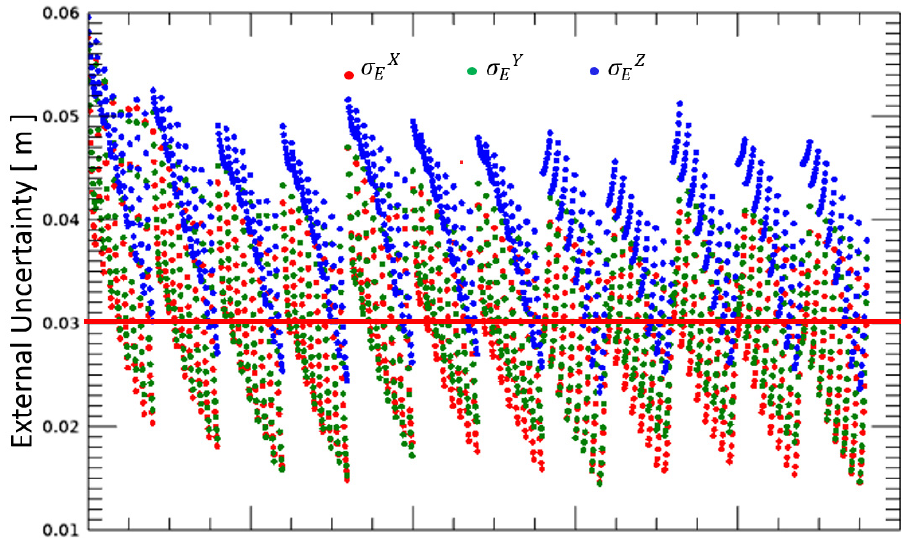
Figure 12. External uncertainty model for amorphous object method on the x-axis. Figure 13. External uncertainty model for the amorphous object method.